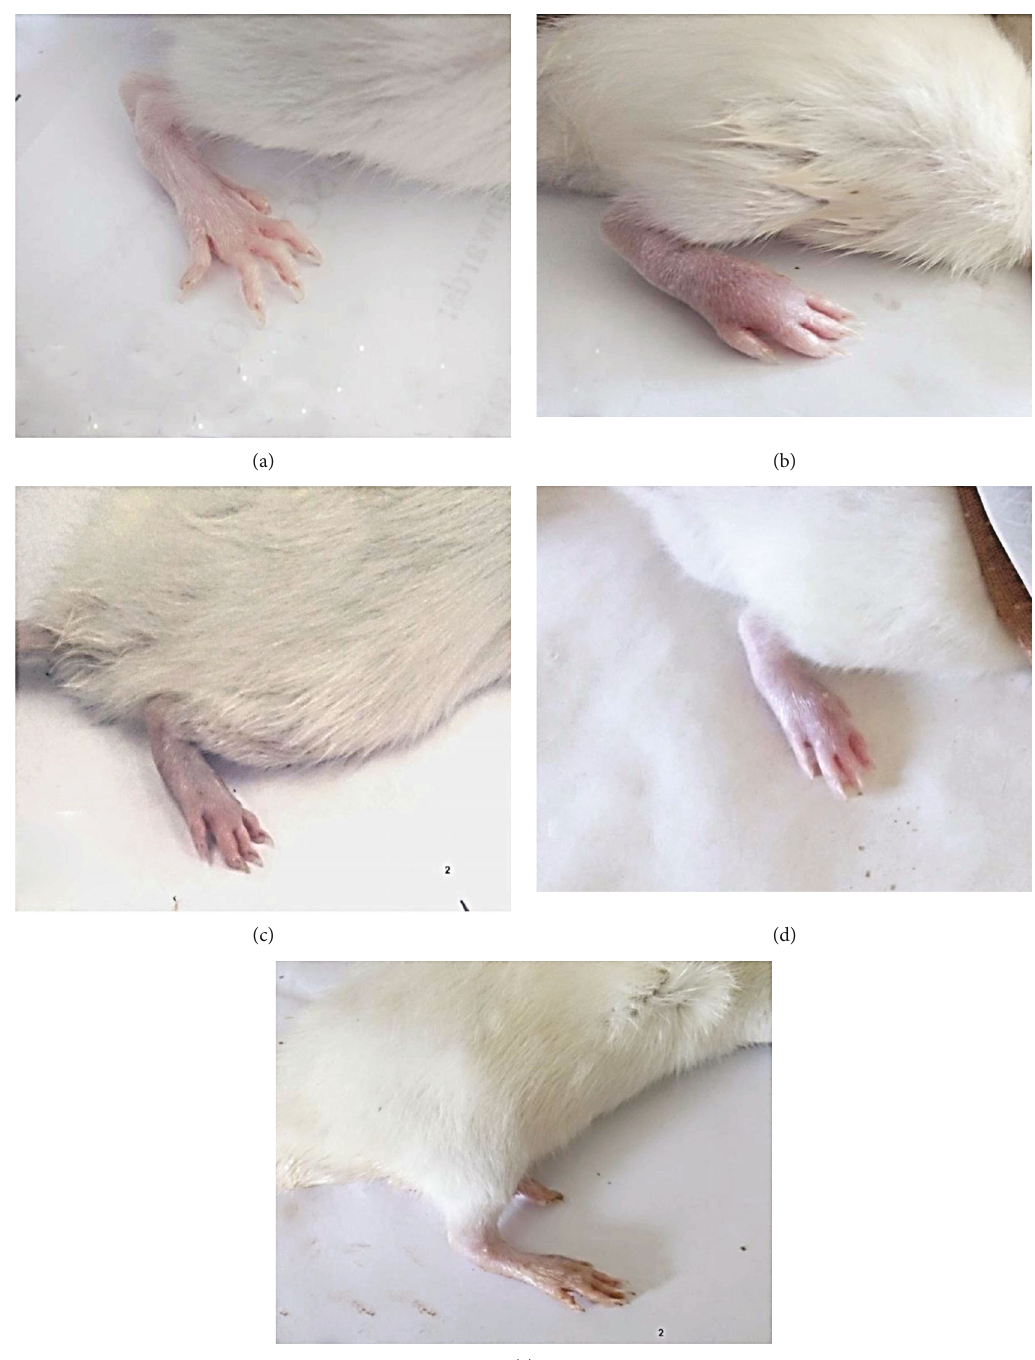
Figure 9: E ff ect of BM-MSCs and/or IMC on gross lesions on the right hind leg paw and ankle joint on day 21 post-CFA induction showing (a) normal rats, (b) CFA-induced arthritic control rats, (c) CFA+BM-MSC-treated rats, (d) CFA+IMC-treated rats, and (e) CFA+BM-MSC +IMC-treated